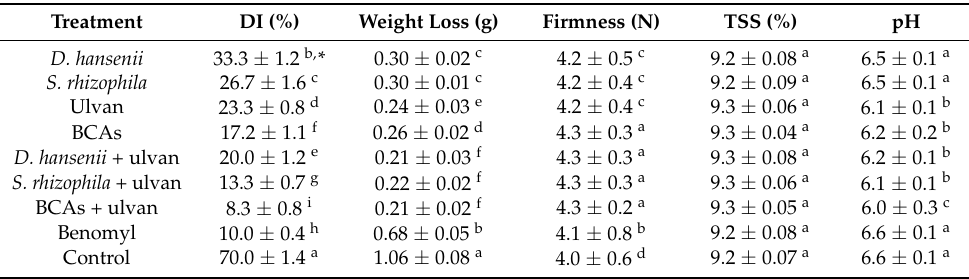
Table 4. Efficacy of D. hansenii , S. rhizophila, and ulvan on natural fruit rot development and fruit quality